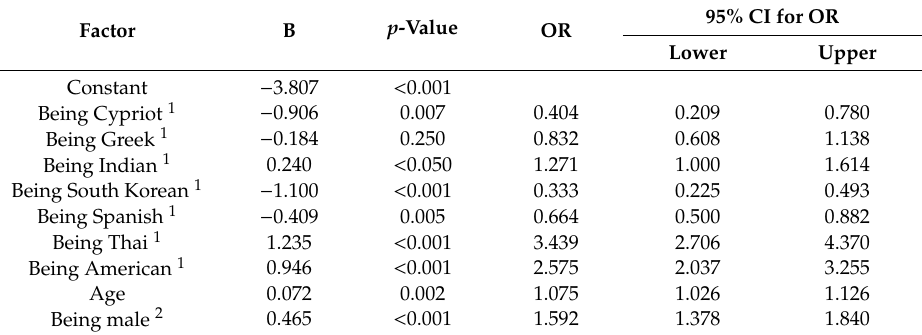
Table 4. Demographic predictors of being a perpetrator of online